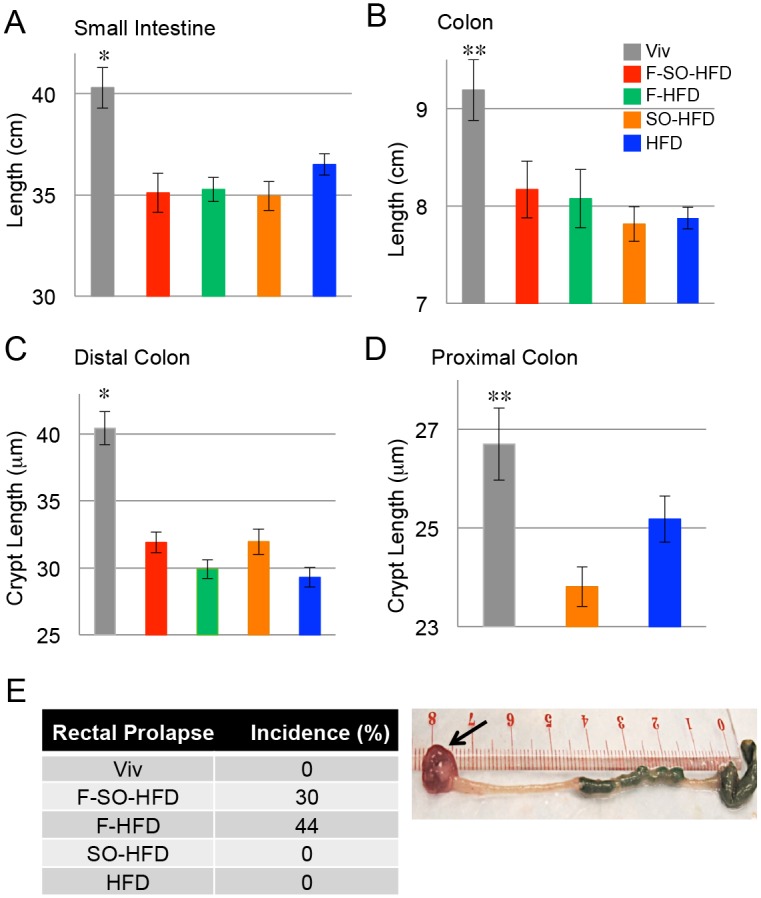
Soybean oil and fructose affect intestinal morphology.Length of small intestine (A) and colon (B) of C57/BL6 male mice on the indicated diets for 35 weeks. N = 6–12 per diet. * Significantly higher than all others. ** Significantly higher than SO-HFD and HFD. Average crypt length in the proximal (C) and distal (D) colon. N = 3–4 mice per group (up to 25 crypts measured/mouse). * Significantly higher than all others. ** Significantly higher than SO-HFD. Significance is defined as P ≤ 0.05 by ANOVA with Tukey’s post-hoc analysis. E) Left, incidence of rectal prolapse at 35 weeks, n = 12 per group. Right, representative image of rectal prolapse (arrow) in a mouse on F-HFD for 35 weeks.